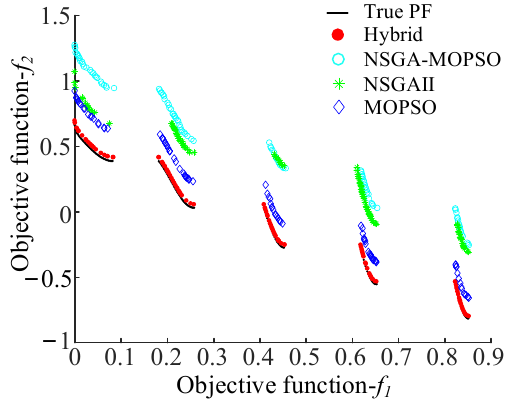
Figure 5. Comparison results for ZDT3.